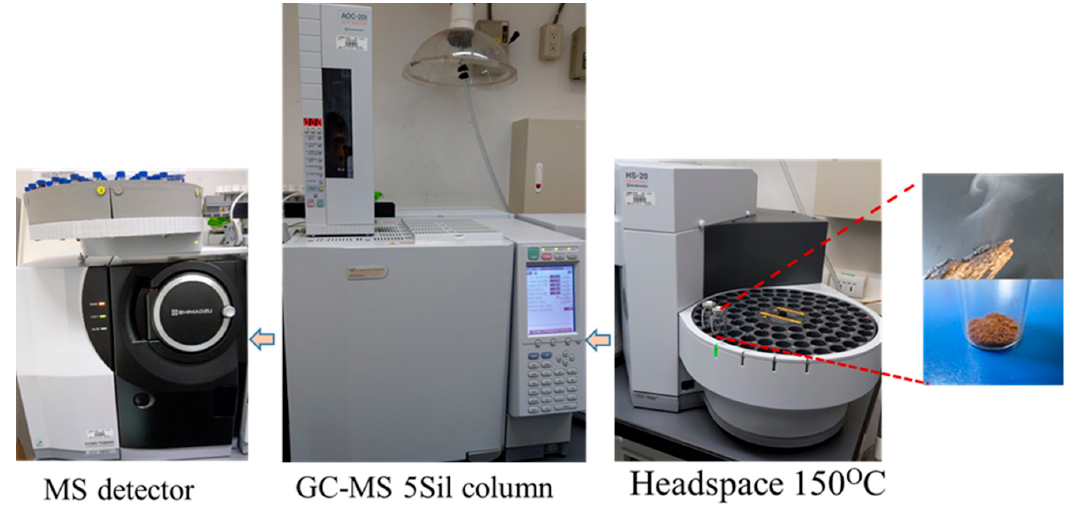
Figure 2. Experimental design and incense smoke detection process. Diagram shows that the incense smoke of agarwoods was generated by headspace preheated system and the smoke was injected directly to GC-MS for analysis.